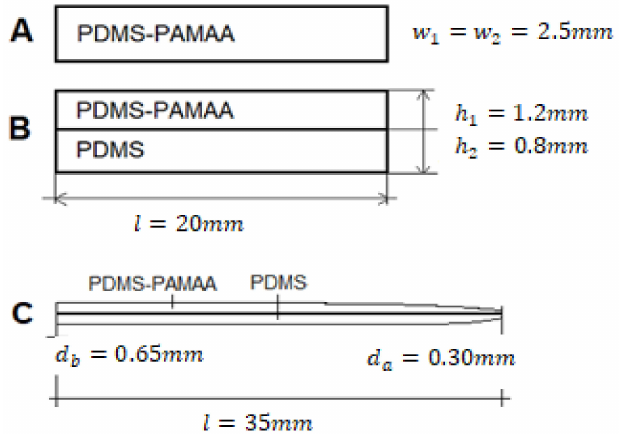
Figure 2. Schematic of the three sample designs, where w, h, and l are the width, height, and length of the outlined samples, respectively. ( A ): Rectangular design consisting of one-layer composite compound material; ( B ): rectangular piggy-back design: the bottom layer is the silicone rubber, and the upper layer is the compound material; ( C ): CI-shape design with an additional layer of composite